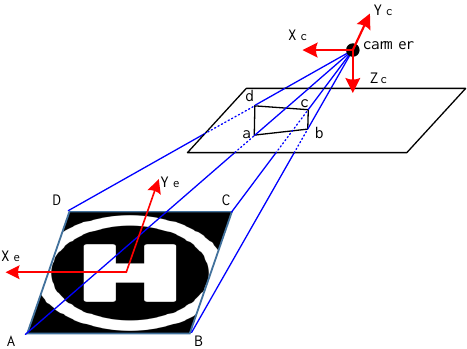
Figure 3. Concept diagram of perspective-n-point (PNP) problem.